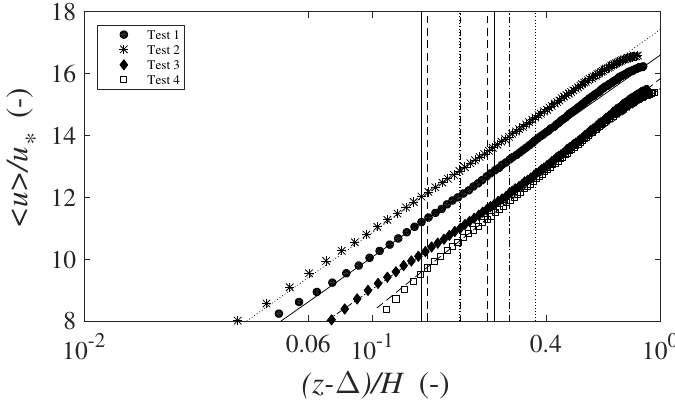
Figure 8. Double-averaged longitudinal velocity profiles and regression lines for the computation of the scale of the roughness elements k s , for Scenario 4 ( κ < 0.405, B = 8.5). The bounds of the regression lines are marked with solid line (Test 1), dash-dot line (Test 2), dashed line (Test 3), and dotted line (Test